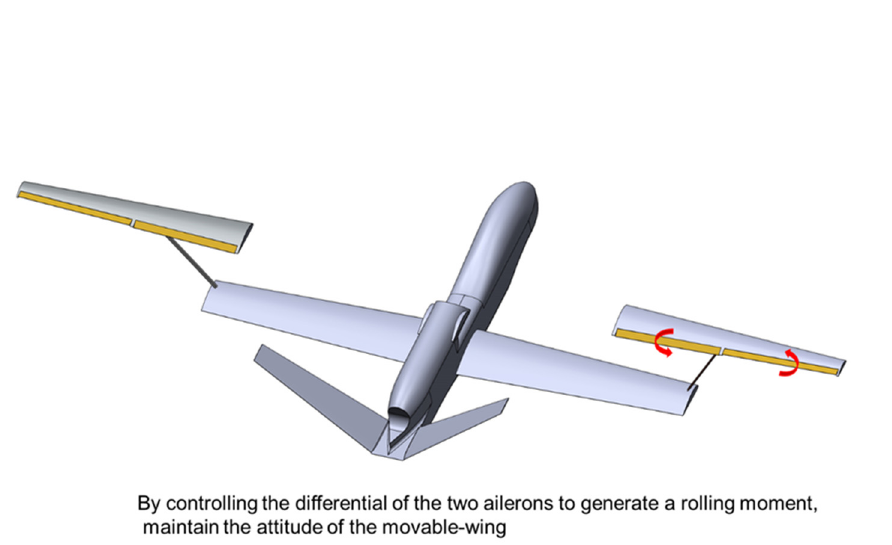
Figure 2. The aileron controls the aircraft to complete the process of morphing. The mono-biplane aerodynamics-driven morphing aircraft can morph at a suitable height and speed according to its flight envelope. Figure 4 shows a typical airplane flight profile. The morphing process is completed at low altitudes and high speeds. At this time, the air density is relatively high, which means that the angle of attack and lift coefficient required for flight is very low. In this state, the wing and aileron have sufficient linear lift, and only a small aileron deflection is required to complete the lift